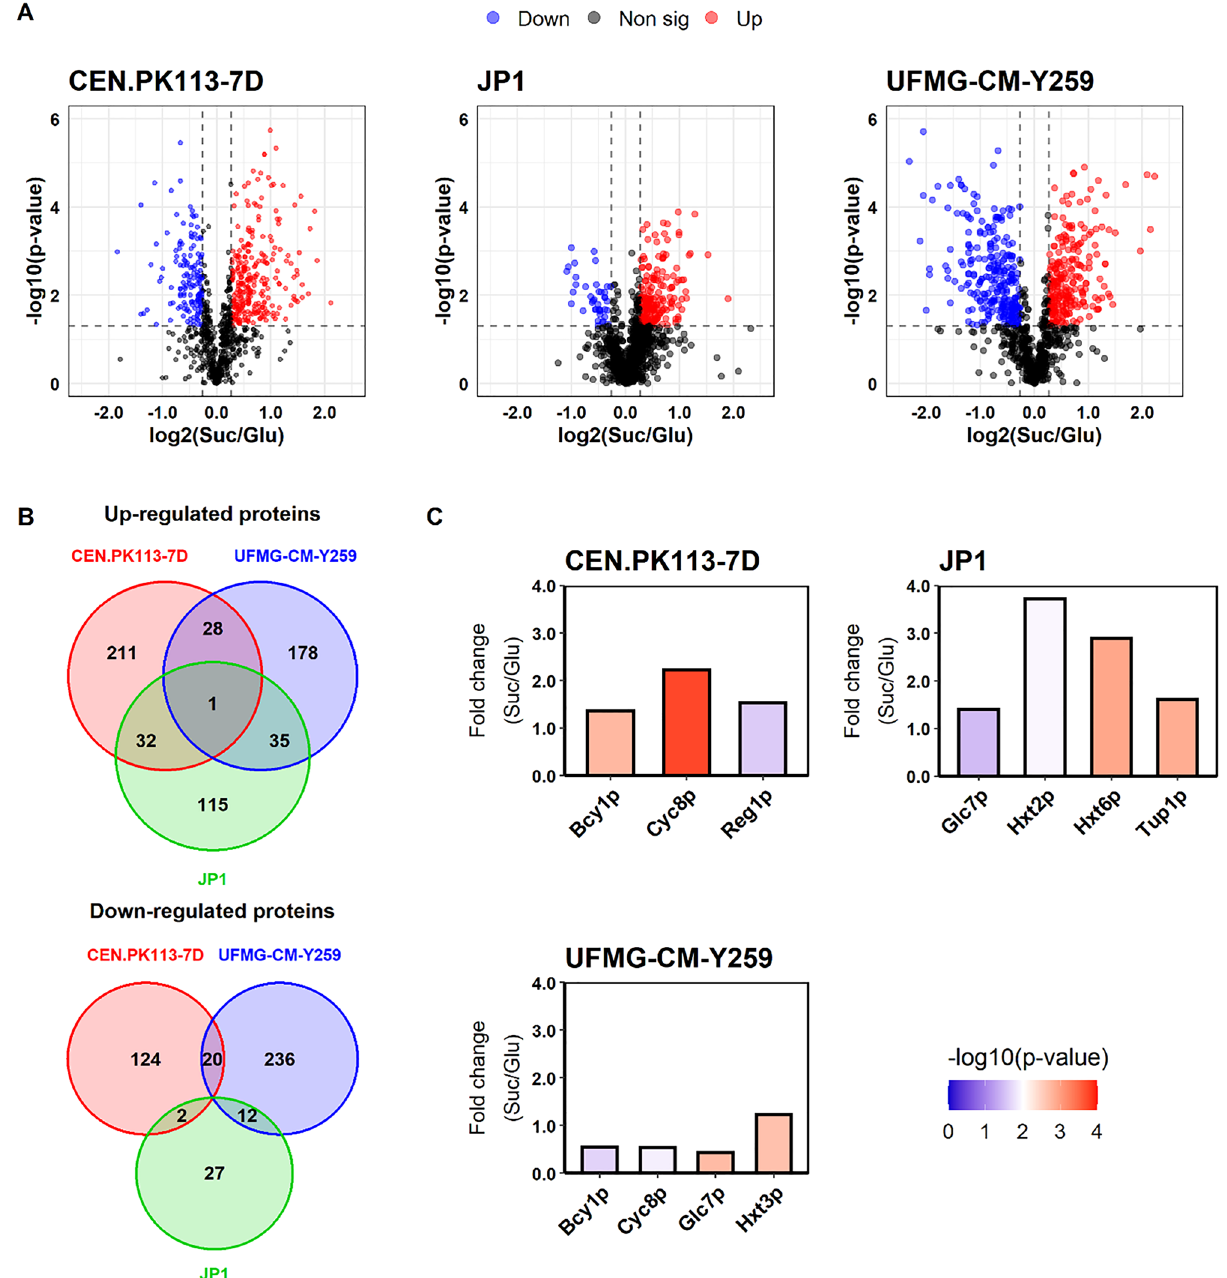
Figure 1. Comparative protein abundance between sucrose and glucose growth conditions for Saccharomyces cerevisiae CEN.PK113-7D, UFMG-CM-Y259, and JP1 strains. ( A ) Volcano plots highlight proteins with statistically significant differential abundance between growth on either substrate as sole carbon and energy source, considering a significance level of p < 0.05. Increased protein levels on sucrose over the glucose condition are shown in red, decreased proteins levels in blue and grey otherwise. ( B ) Venn diagrams illustrate the extent of differentially abundant proteins shared among the strains. ( C ) Fold changes in the levels of some proteins known to play a role in sucrose metabolism and regulation, hexose transport, and in the protein kinase A (PKA) signaling cascade. Color coding indicates the statistical